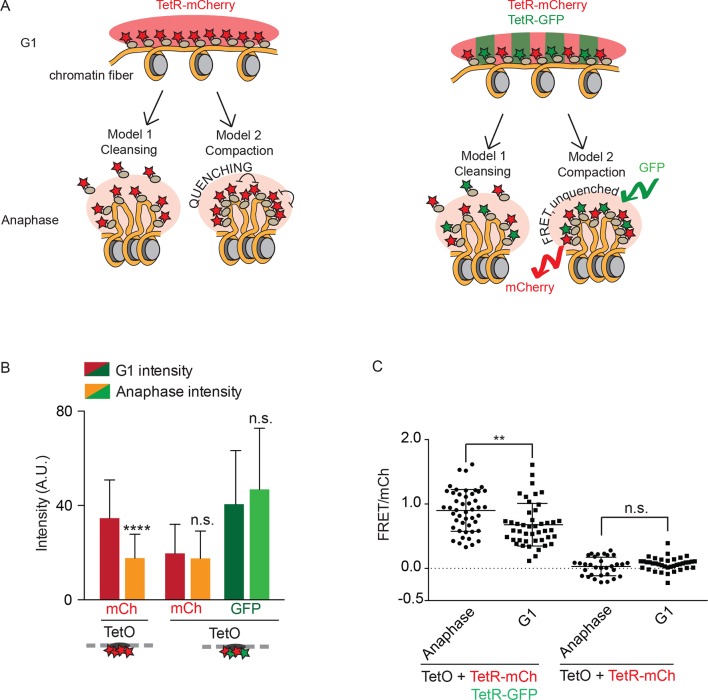
Fluorophore quenching causes changes of TetO/TetR intensity over the cell cycle.(A) Two models to explain anaphase-specific decrease in fluorescence brightness (cleansing and quenching, see text for explanations). Shown are the consequences of each model in G1 and anaphase, in the case of cells carrying TRP1:TetOs and either expressing only TetR-mCherry or TetR-mCherry and TetR-GFP. (B) G1 and anaphase TetO/TetR-mCherry intensities in cells carrying TetO and expressing only TetR-mCherry (left) or TetR-mCherry and TetR-GFP (right). Data are means and standard deviations, unpaired Student’s t tests were performed to test significance, **** p<0.0001 and n.s. not significant. (C) FRET values for indicated strains. Plotted are mean values and standard deviation. Unpaired Student’s t tests were performed to test significance, ** p<0.01 and n.s. not significant.